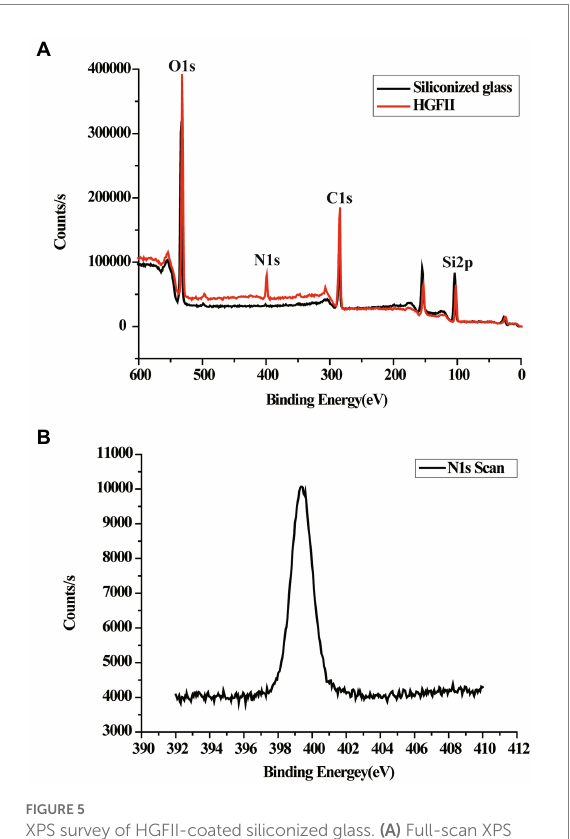
FIGURE 5 XPS survey of HGFII-coated siliconized glass. (A) Full-scan XPS survey of O1s, N1s, C1s, and Si2p. (B) N1s XPS curve of HGFII- coated siliconized